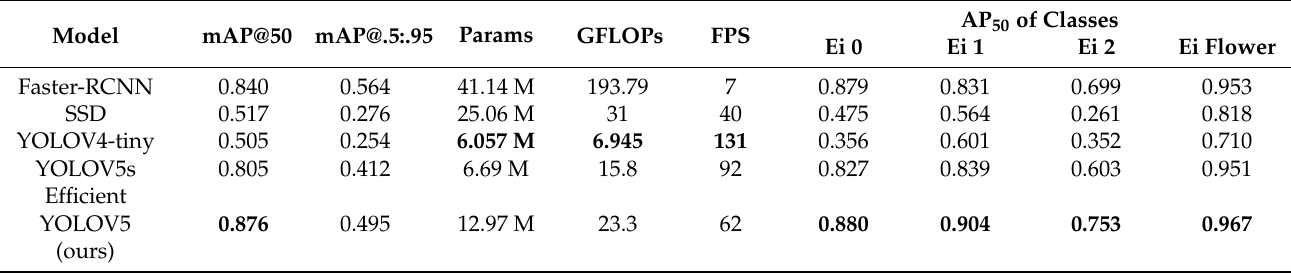
Table 2. Comparison of various detection